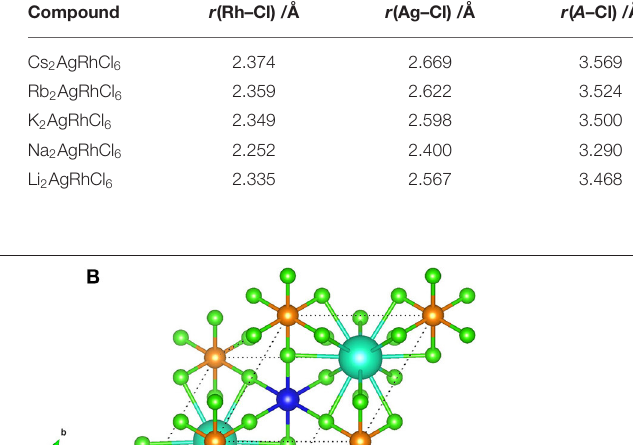
TABLE 2 | Selected bond distances of A 2 AgRhCl 6 ( A Compound